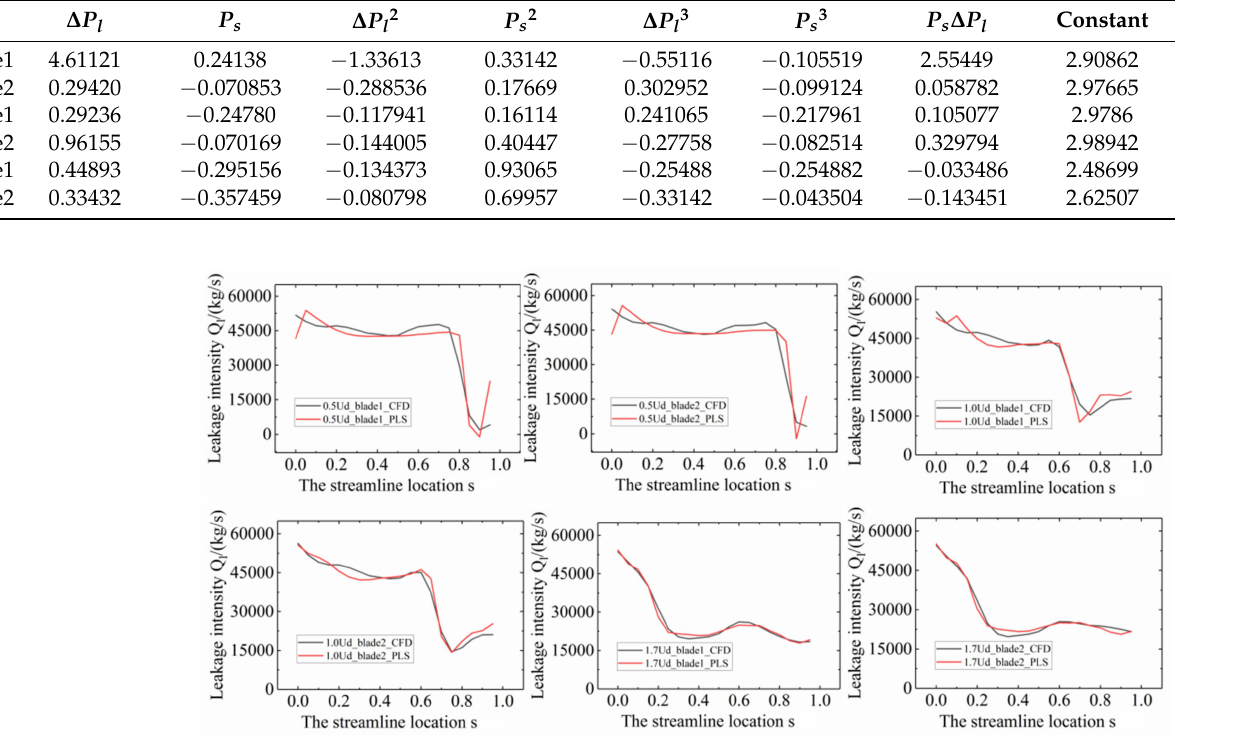
Figure 17. Comparison of the regressive and original tip leakage